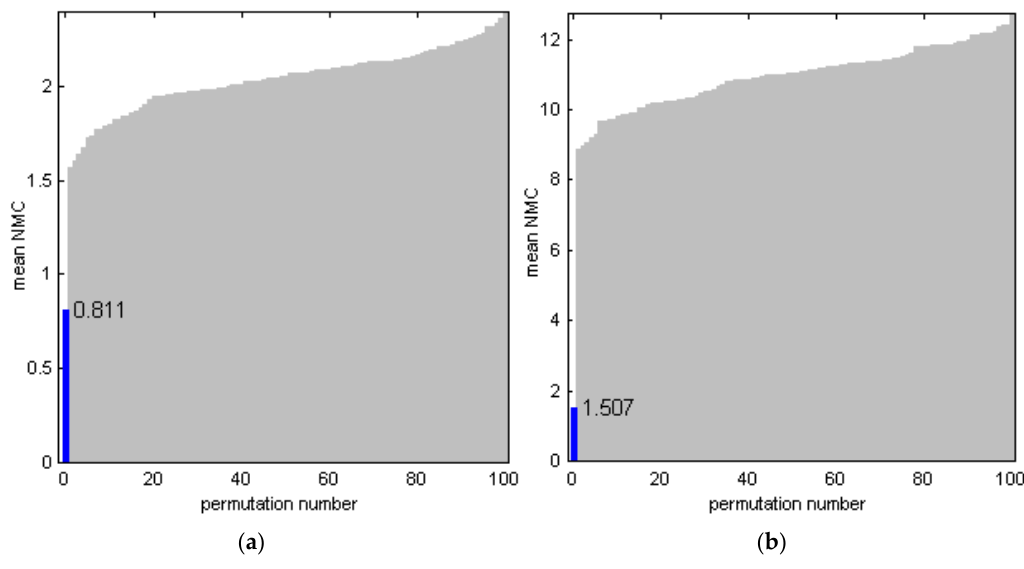
Figure 10. Permutation tests of partial least-squares discriminant analysis (PLS-DA) models for sensor measurements: ( a ) Series A, and ( b ) refined Series B (As33 and Bs140 models in Table 1, respectively). Validation with a random 15% subset at 1000 iterations was used; sorted mean number of misclassified measurements ( NMC ) metrics are presented. Blue bar at zero permutation number corresponds to original non-permuted data.